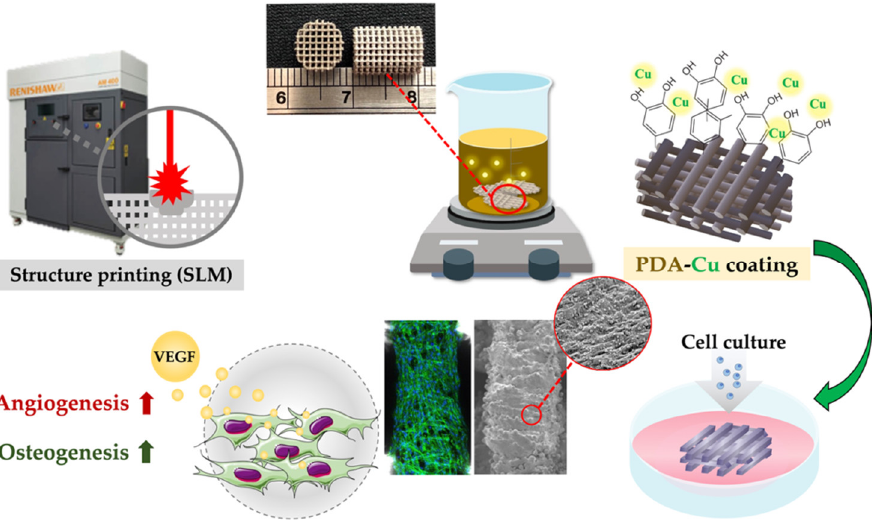
Figure 1. Schematic diagram of the SLM-fabricated Ti6Al4V scaffold coating with Cu ion grafted by DA, which gave the scaffold with the ability to promote angiogenesis and osteogenesis by the releasing Cu ions.